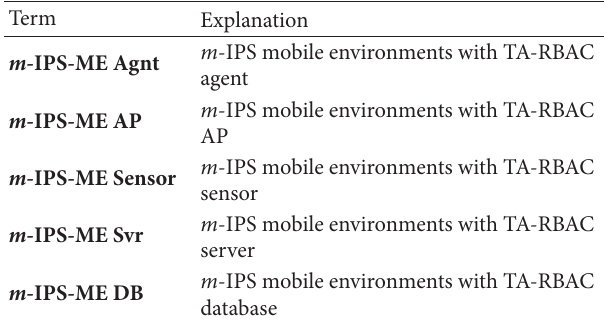
Table 3: Term and